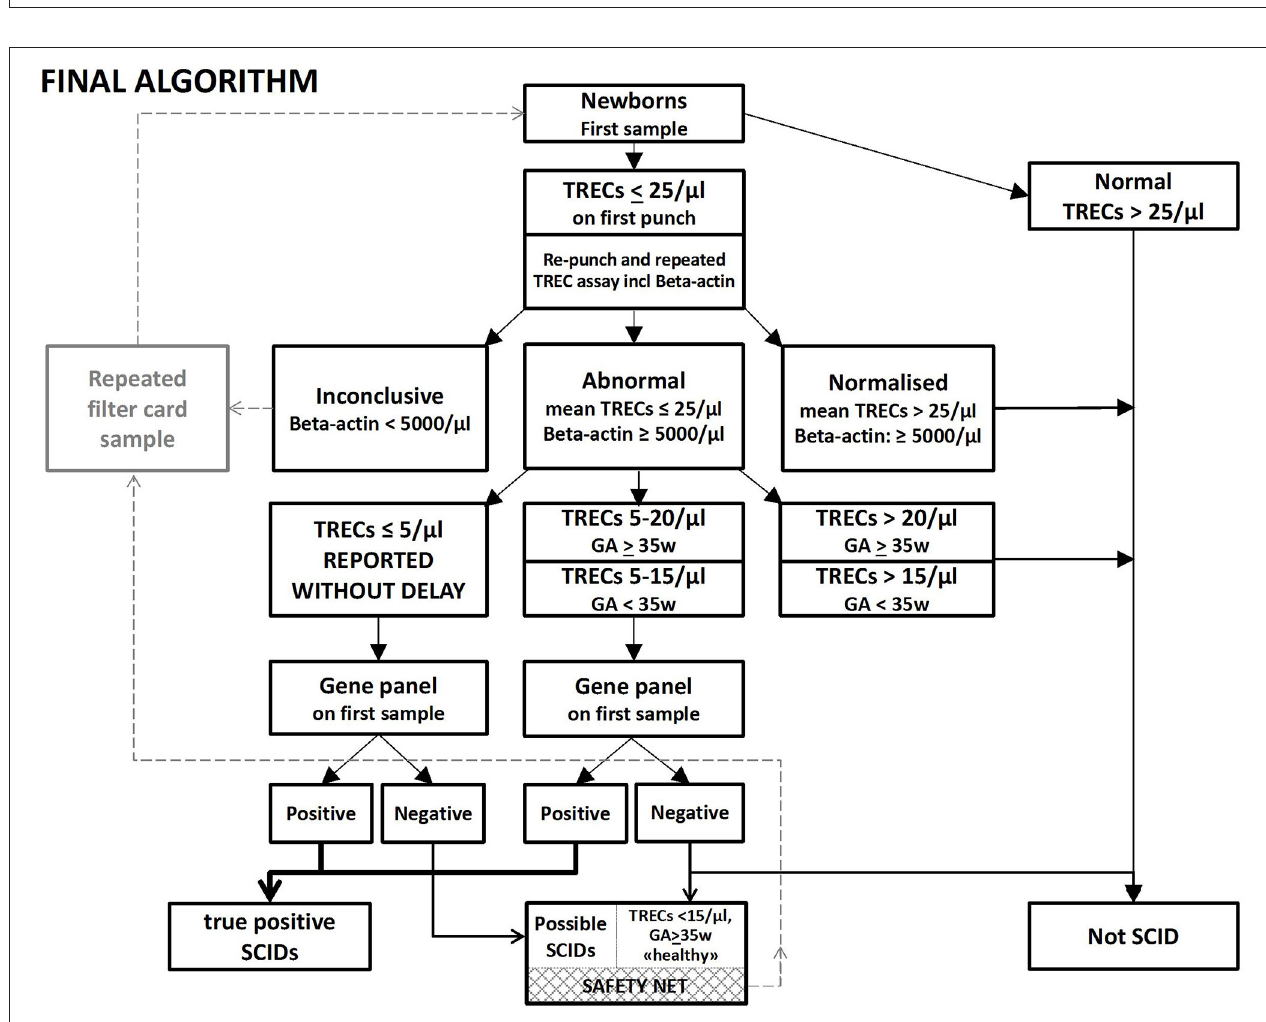
FIGURE 2 | Rapid NGS gene panel testing integrated in the NBS laboratory algorithm for SCID and other T cell lymphopenias, Final algorithm. Samples below 25 TRECs/ µ L are re-punched and TREC analyses repeated twice on DNA from the new punch. A new DBS sample is requested if low levels of β -actin ( < 5,000/ µ L) are found. Samples with TRECs below 20/ µ L (15/ µ L for prematures) are immediately NGS gene panel tested. Samples with TRECs below 5/ µ L are reported without delay, regardless of the NGS findings. If TRECs are below 15/ µ L and NBS-NGS gene panel negative in an apparently healthy child with normal weight born to term, a second DBS sample is requested as a “safety net.” And if the TREC values are low on the second sample as well, the pediatric immunologist will be alerted, and the child followed further up with clinical investigations.